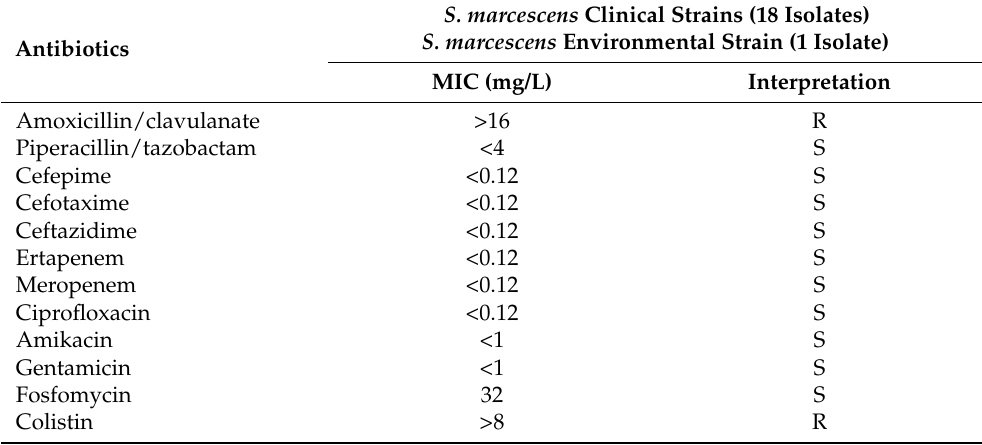
Table 1. Antimicrobial susceptibility of S. marcescens clinical and environmental strains.